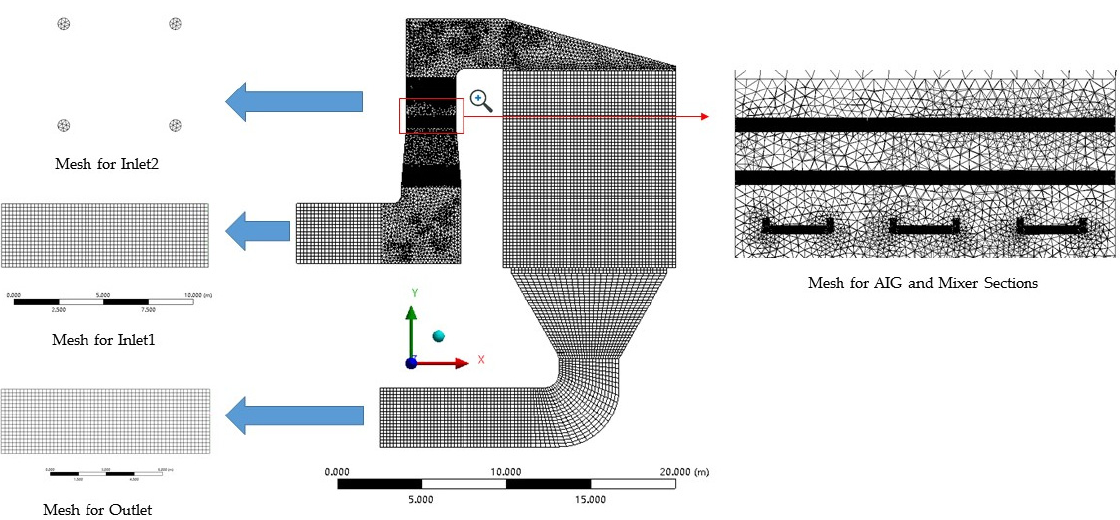
Figure 2. Mesh division of the CFD model.